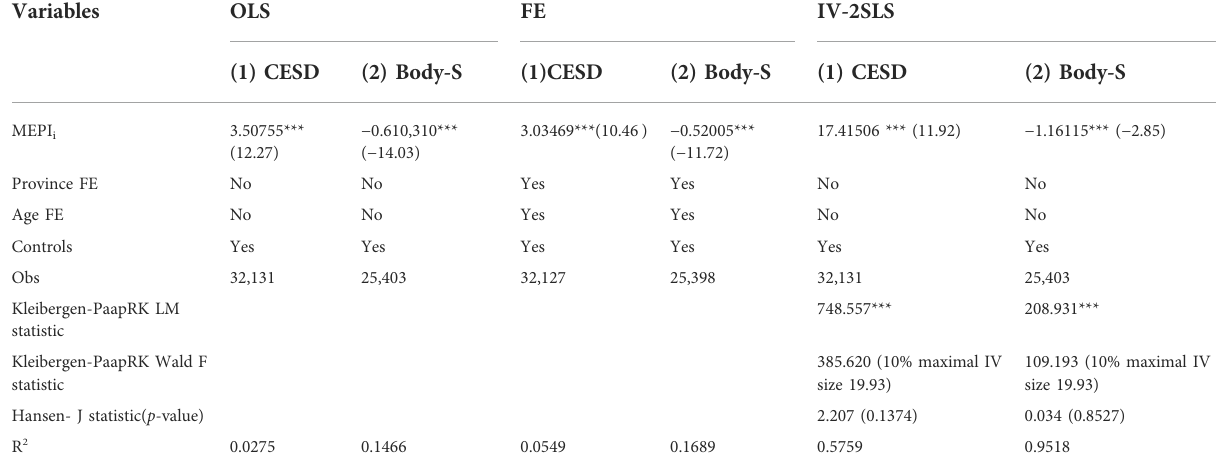
TABLE 5 Robustness test: replace the explained variable.